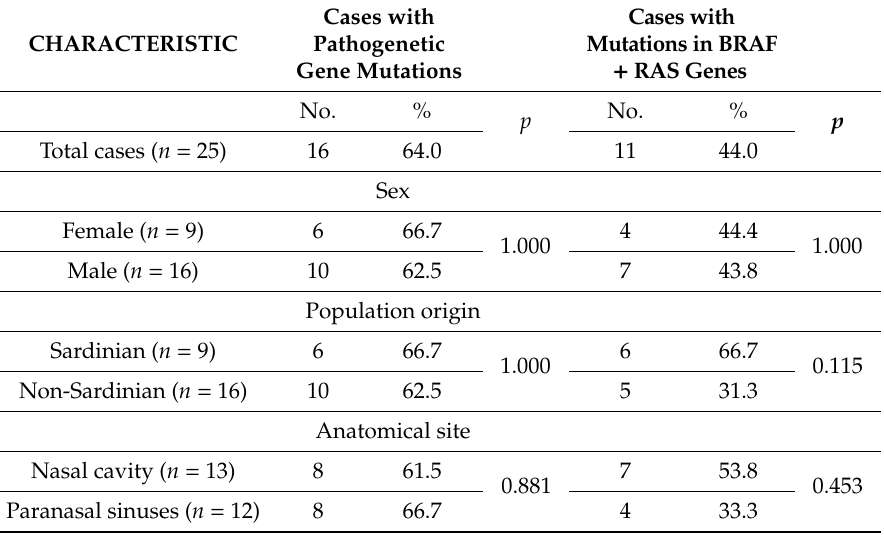
Table 2. Distribution of pathogenetic mutations in the SNM